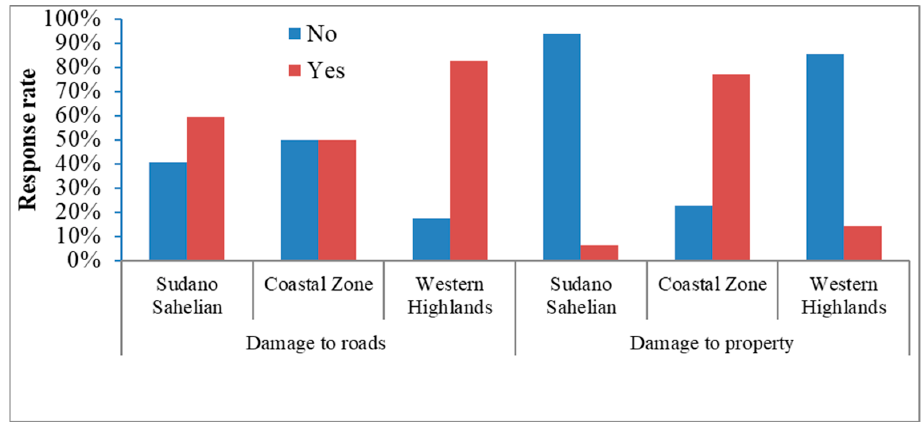
Figure 6. Damage to infrastructure. Notes: Chi-square livestock = 622.77, p = 0.000; Chi-square crop = 537.676, p = 0.000.